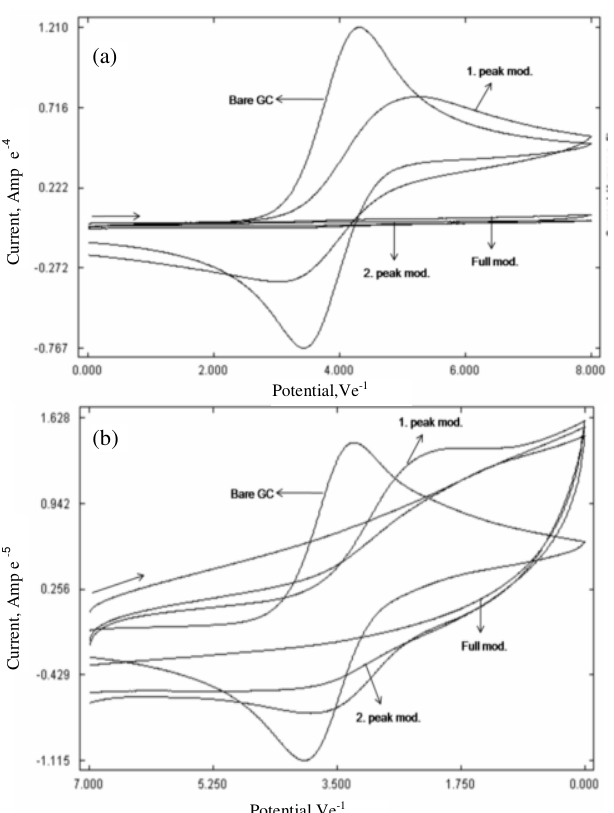
Figure 8 . Overlaying surface voltammograms for full peak, first peak and second peak (a) the bare GC and HIBD modified GC with ferrocene and than (b) the bare GC and HIBD modified GC with ferricyanide